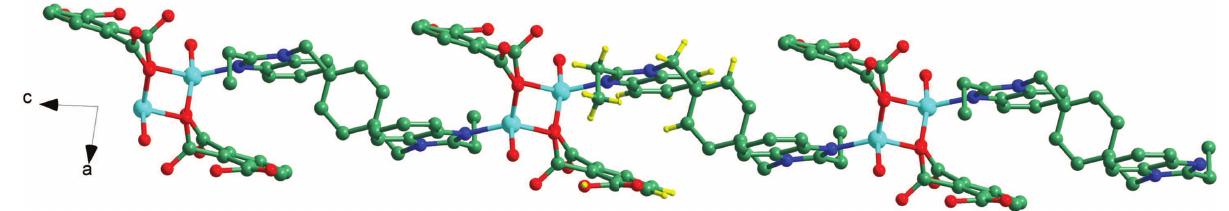
Figure 2: The 1D chain of the title complex.